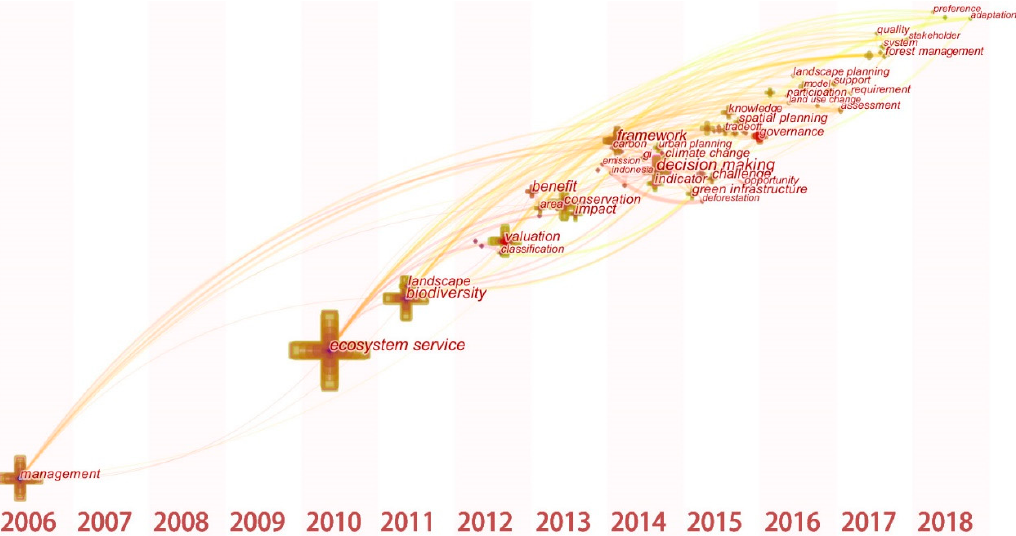
Figure 6. Burst terms of keywords based on time-zone in the research. The size of the plus symbol represents the frequency of keywords appearing in the sample articles.